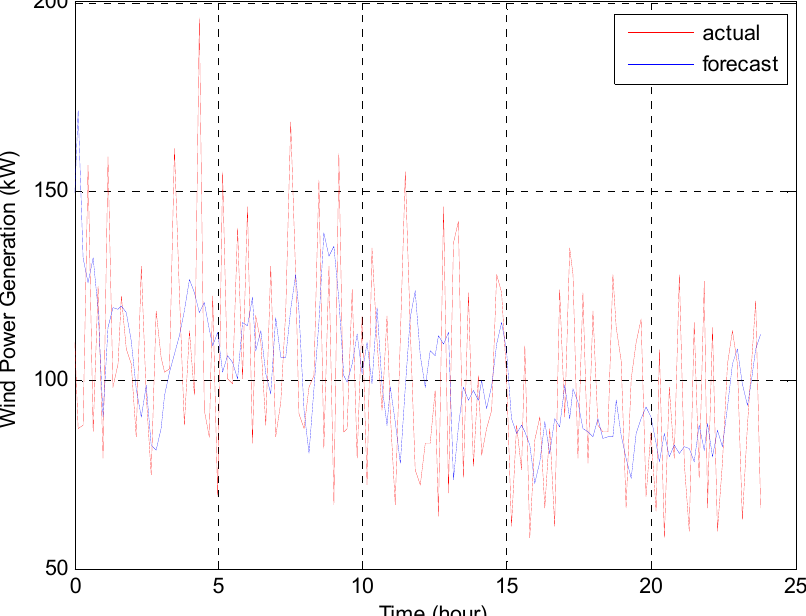
Figure 11. Test results with the back propagation neural network method for typical summer